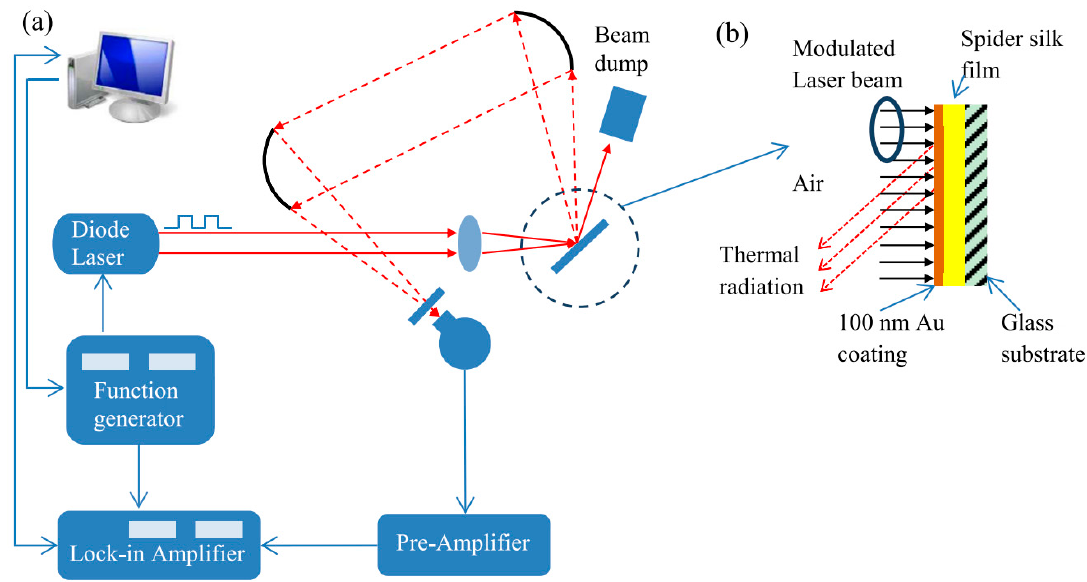
Figure 10. ( a ) Schematic for photothermal technique (PT) ( b ) Principle of photothermal technique (PT). Reprinted with permission of the Elsevier. [71].